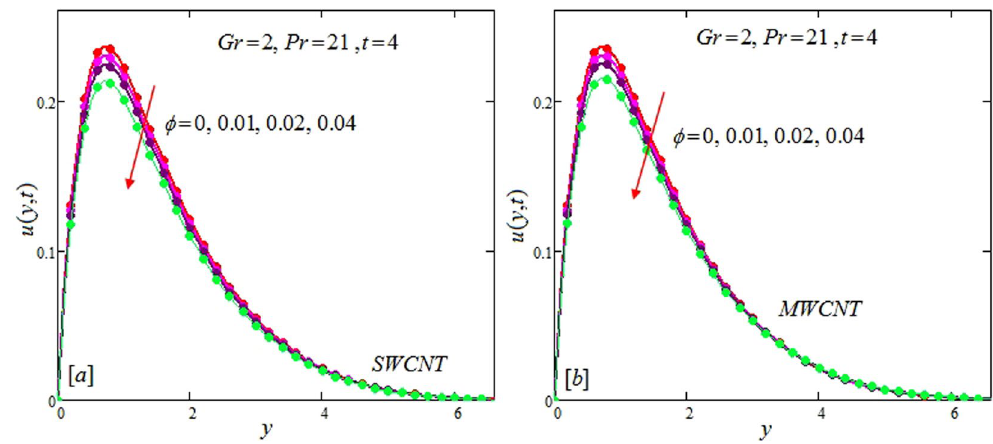
Figure 7. Velocity profiles for single and multiple wall CNTs for different values of volume fraction of CNTs.